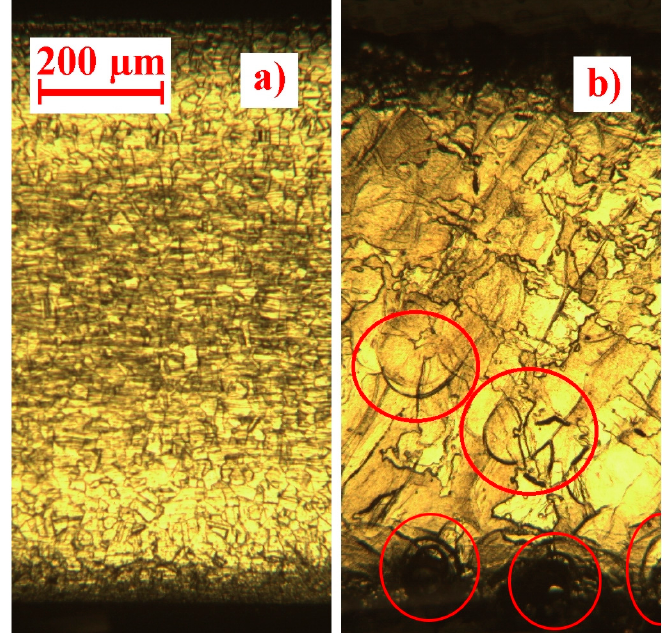
Figure 10. Magnified images of the samples showing the microstructure; ( a ) Cold-rolled steel sheet; ( b ) PBF produced sheet. Areas of interest circled in red.